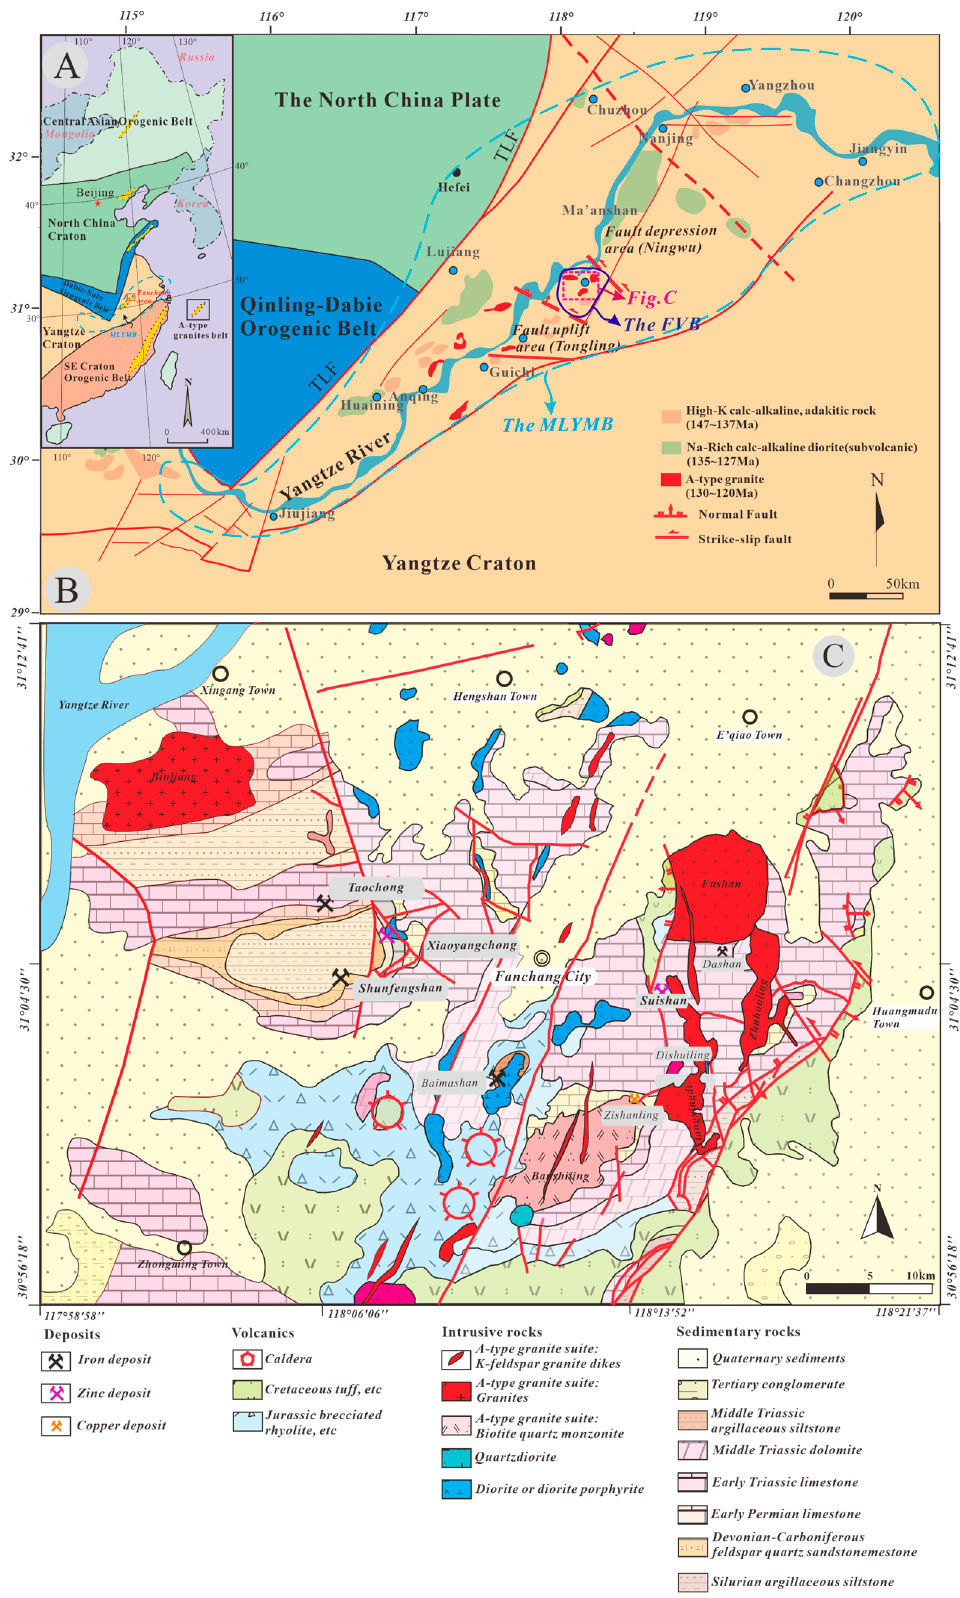
Figure 1. ( A ) Tectonic sketch map showing A-type granite belts in eastern China (modified from [76]); ( B ) sketch map showing the A-type granites of the MLYMB (modified from [72] and [87]); ( C ) main ore deposits related to the A-type granites of the FVB.